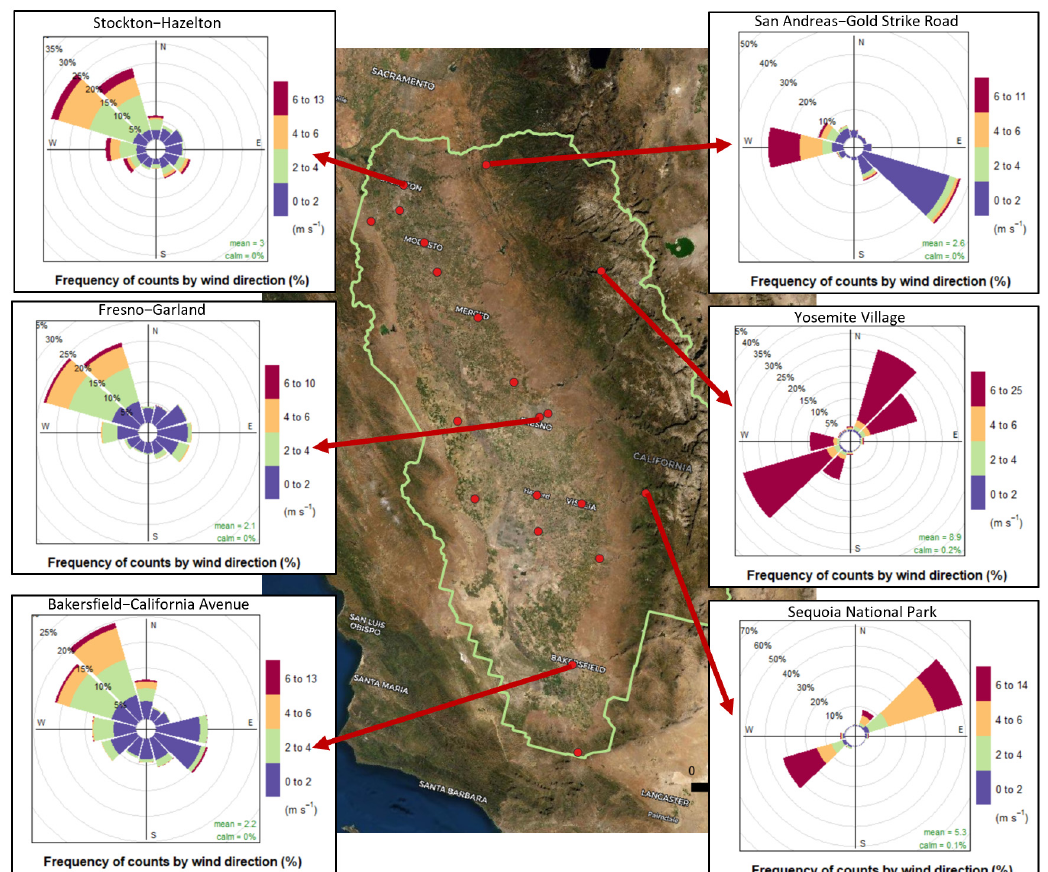
Figure 6. Wind Roses at different locations in the study area.